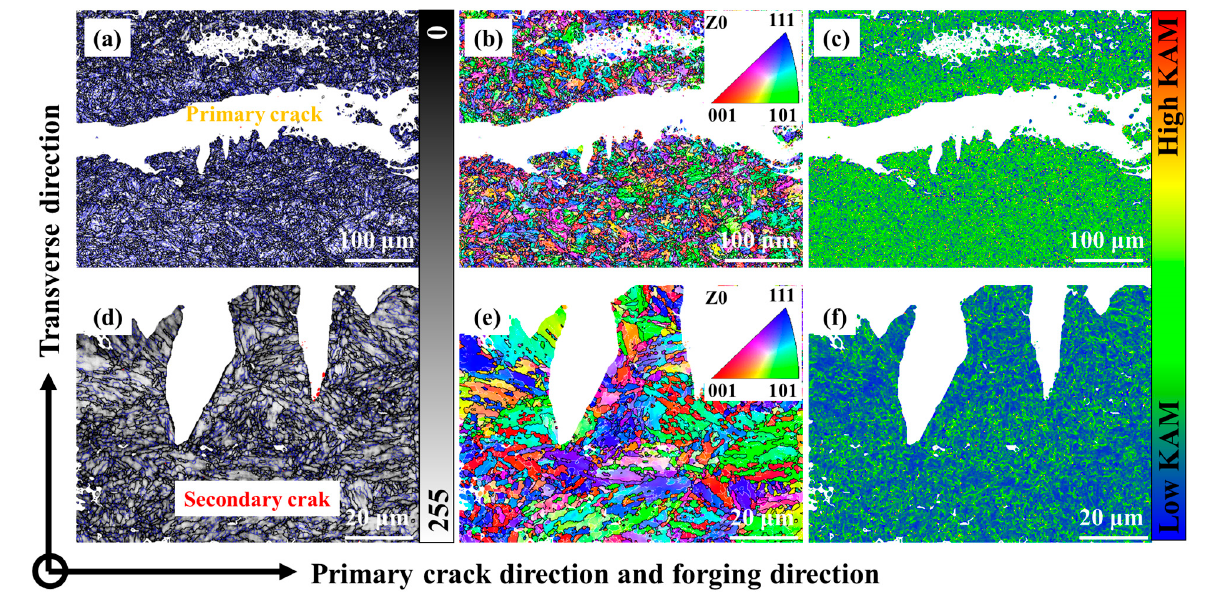
Figure 13. FCG path of 0.12C-3.13Mn steel: ( a – c ) Macroscopic morphology; ( d – f ) Local magnification region. ( a , c ) are the band contrast maps marked by grain boundaries; ( b , e ) are the IPF maps; ( c , f ) are the KAM maps.